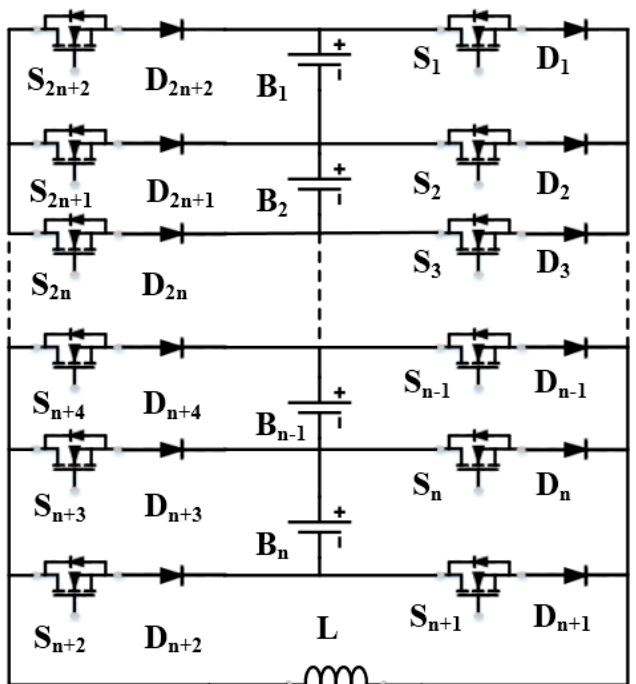
Figure 1. Single switched-inductor equalizer proposed in [5].